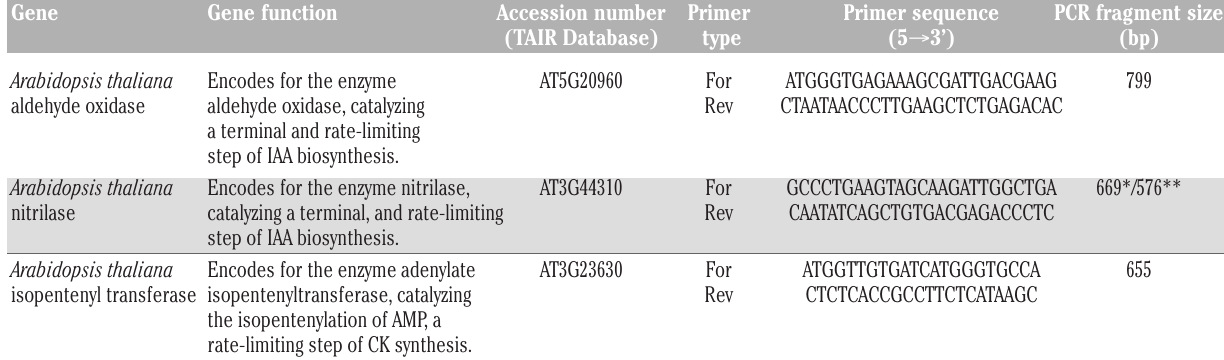
Table 1. Primers used for the amplification of gene sequences.